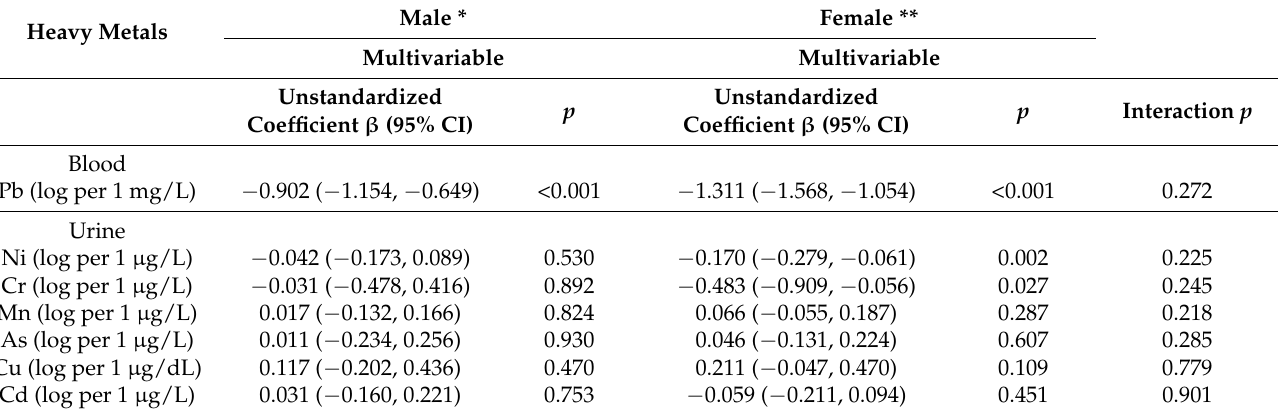
blood Pb, urine Ni and urine Cr were significantly negatively associated with MCHC. Table 7. Association of heavy metals with MCHC using multivariable linear regression analysis by